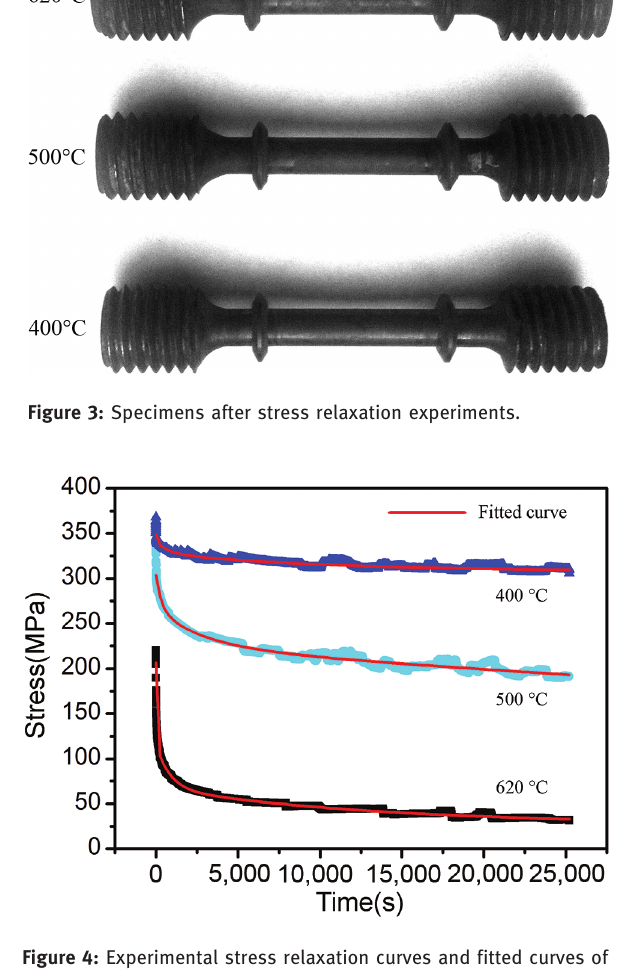
Figure 4: Experimental stress relaxation curves and fitted curves of SA302Gr.C at different